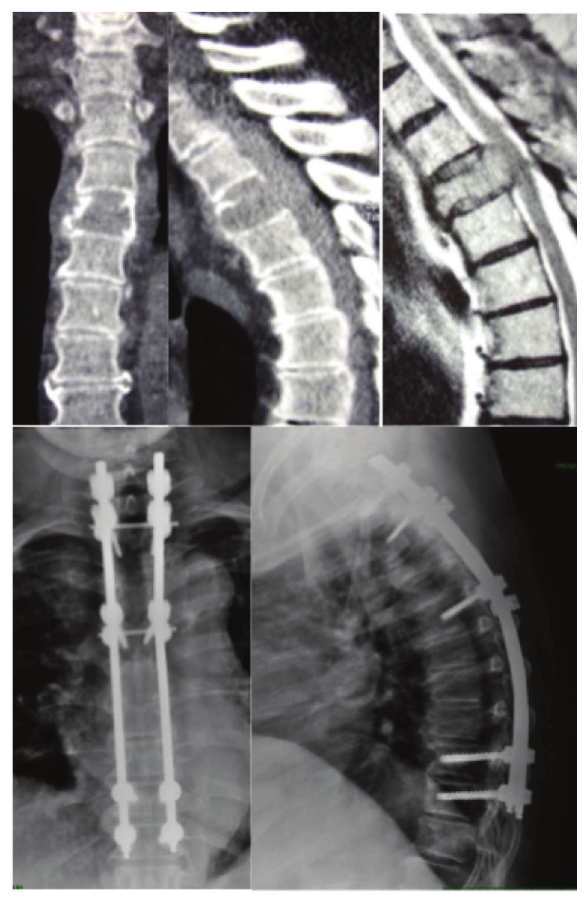
Figure 4: CT scan and MRI of a 71-year-old, obese female (120Kg) with osteolysis of the T4. Hybrid construct performed percuta- neously in the lower tract (T9-10) and by open approach in upper part (T1-2/5). No failure of the implant at 1-year follow-up